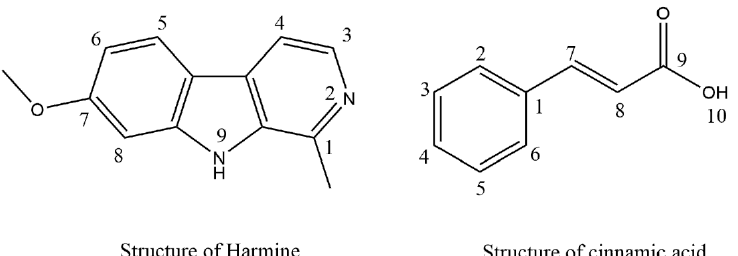
Figure 1. Structure of Harmine and cinnamic acid.